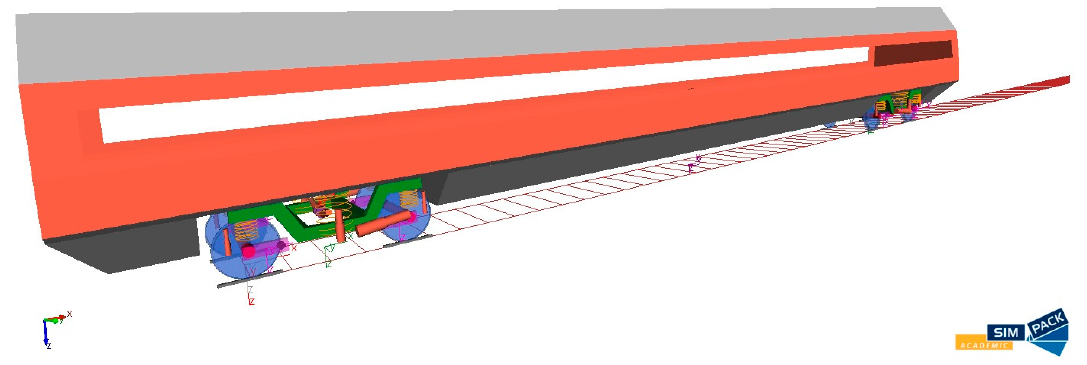
Figure 6. An illustration of the multibody wagon model created in the Simpack package.